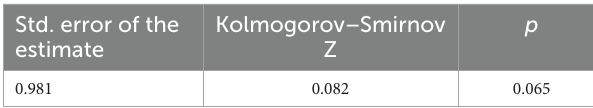
TABLE 2 Residual normality